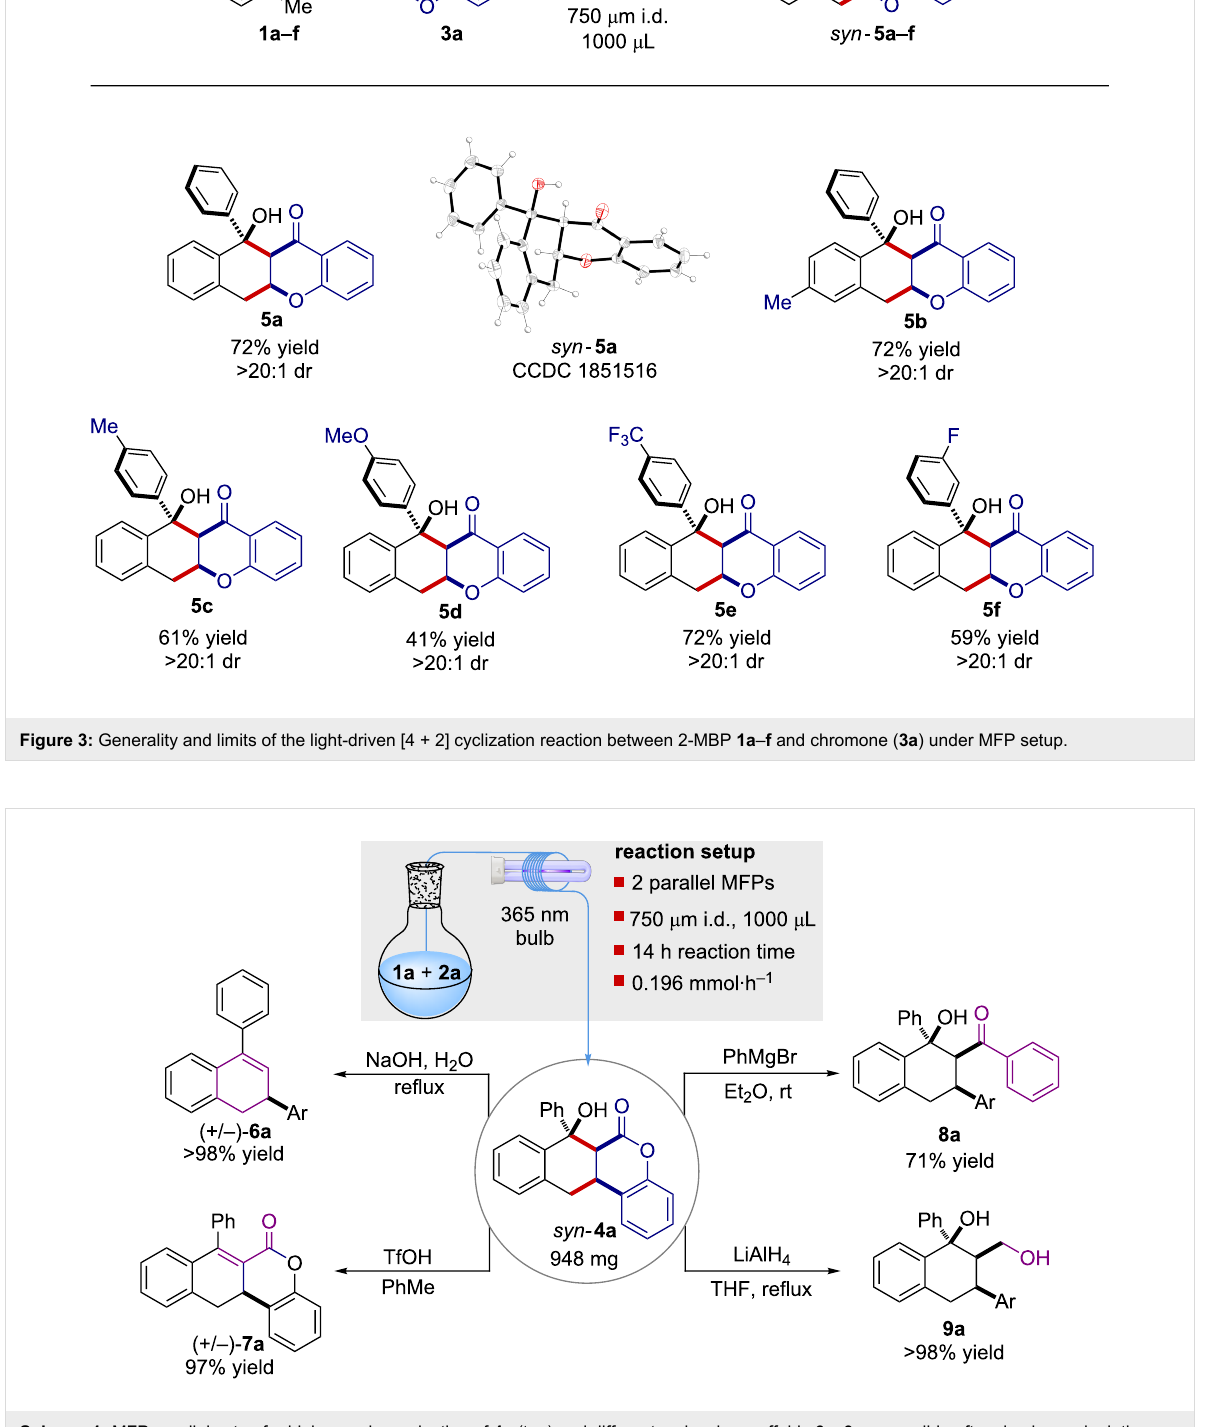
Scheme 1: MFP parallel setup for higher scale production of 4a (top) and different molecular scaffolds 6a–9a accessible after simple manipulation (Ar = o -OH-C 6 H 4